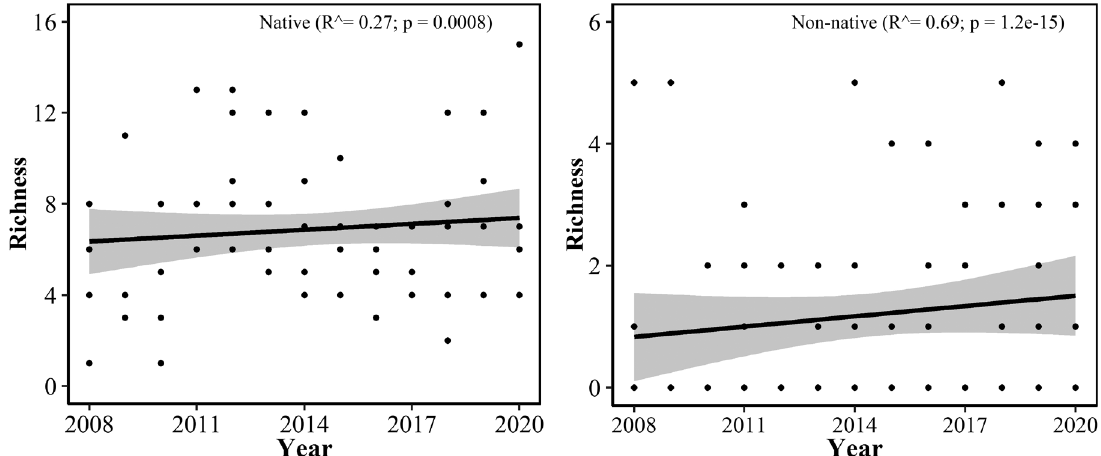
FIGURE 3 | Observed fish-species richness vs . time. Observed fish-species richness native (left) and non-native (right) by sampling year in the area of influence of the Porce III reservoir. The generalized linear models and their confidence interval have been added. Each point represents an environment.